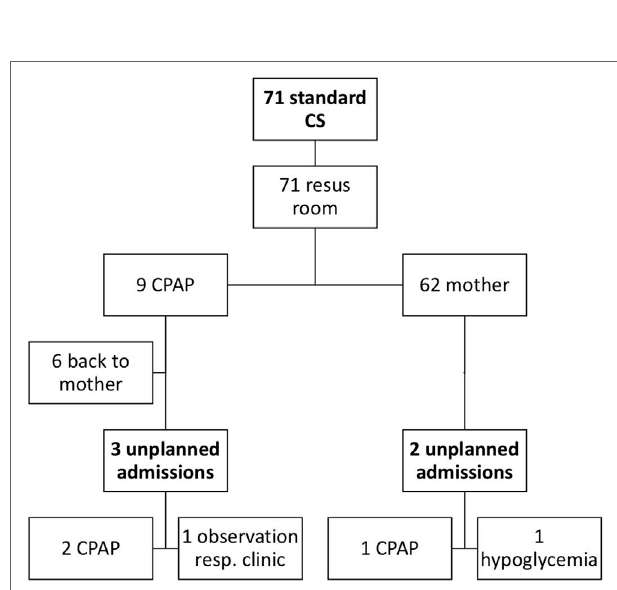
FigUre 2 | Overview of neonatal outcome after standard cesarean sections (CS). A flowchart of the neonatal outcome after standard CS is shown. Resus room, resuscitation room; Resp clinic, clinical symptoms of respiratory pathology.